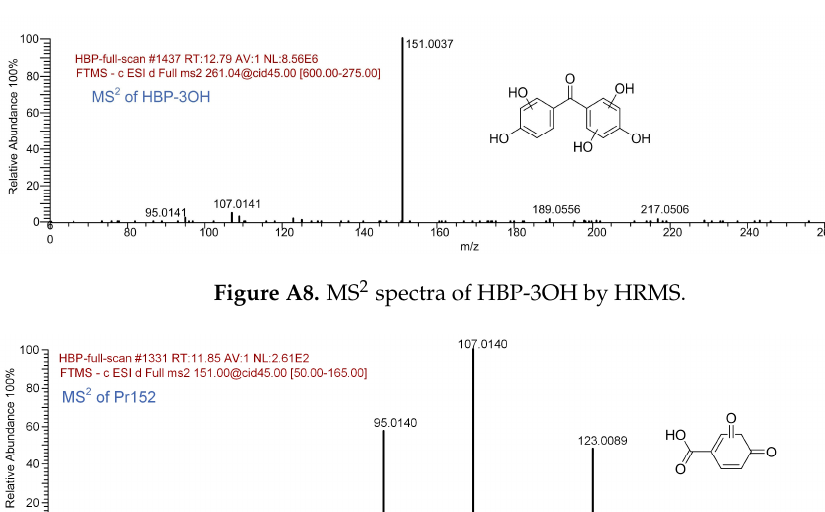
Figure A7. MS 2 spectra of HBP-2OH-a and HBP-2OH-b by HRMS.